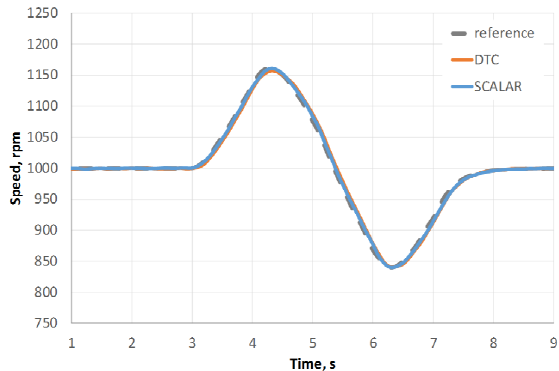
Fig. 4. Drive speed response profile around 1000 rpm at pulse test cycle.